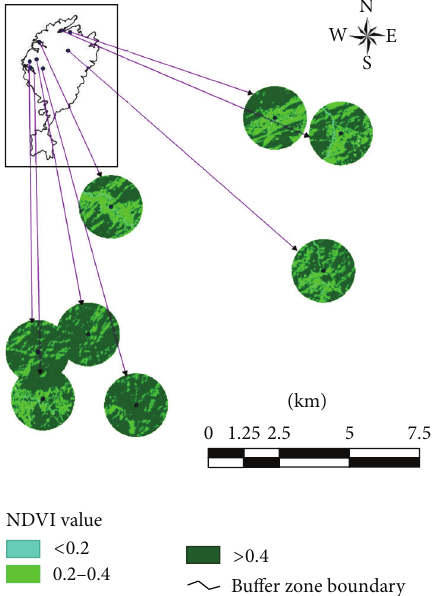
Figure 4: Vegetation density map in terms of NDVI classes in 3km buffer area surrounding dense road points for